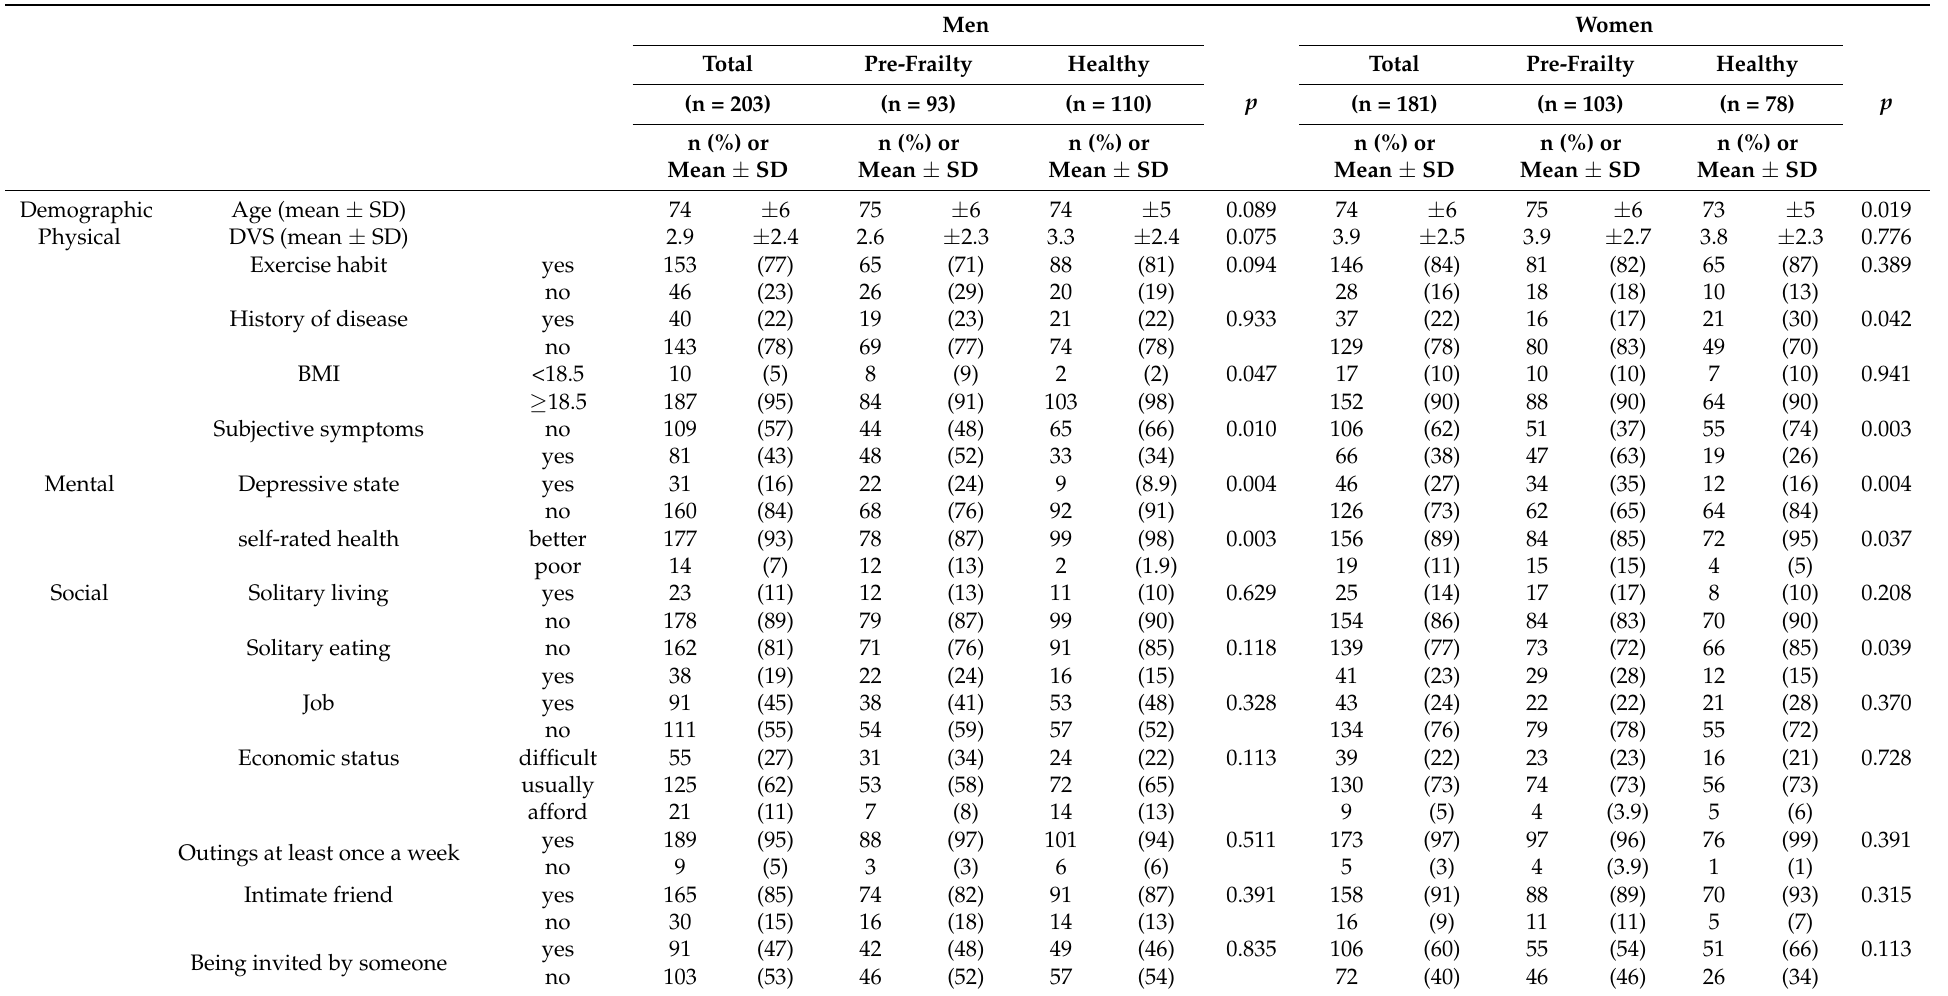
Table 1. Comparison of Japanese community-dwelling older adults in the pre-frailty and healthy